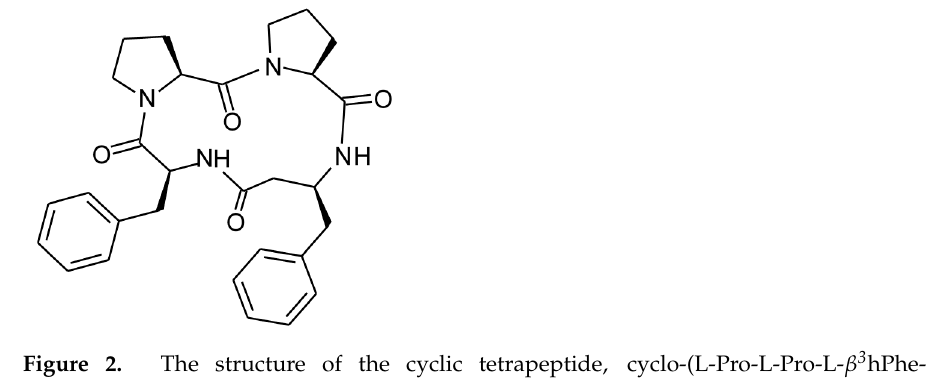
Figure 2. The structure of the cyclic tetrapeptide, cyclo-(L-Pro-L-Pro-L- β 3 hPhe-L-Phe-). ( 3S,9S,13S,16S )-9,13-dibenzyl-1,7,10,14-tetraazatricyclo[14.3.0.0 3,7 ]nonadecane- 2,8,11,15-tetrone (IUPAC